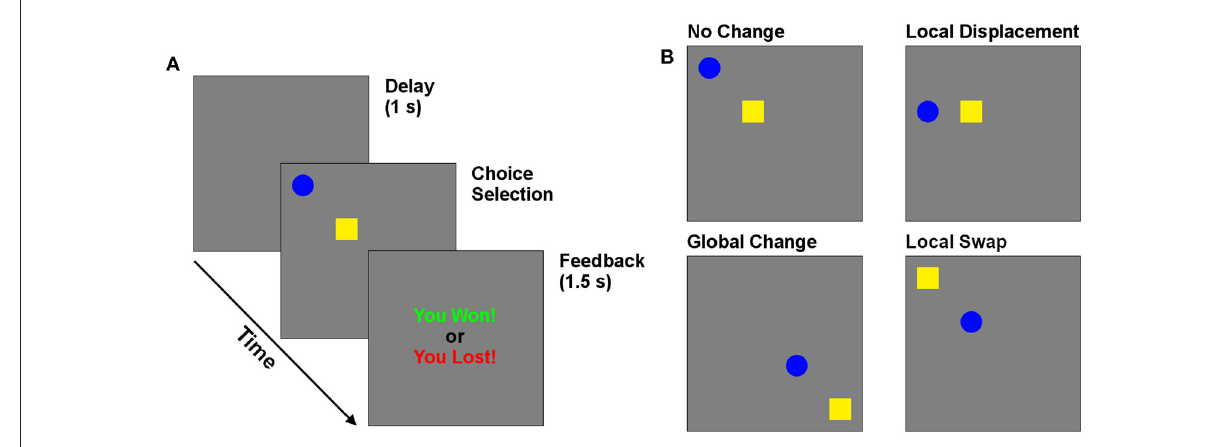
FIGURE1 Behavioral task. (A) Timeline of trials in the matching pennies game. (B) Reconfiguration of targets, which could undergo local (swap and displace) and global changes in